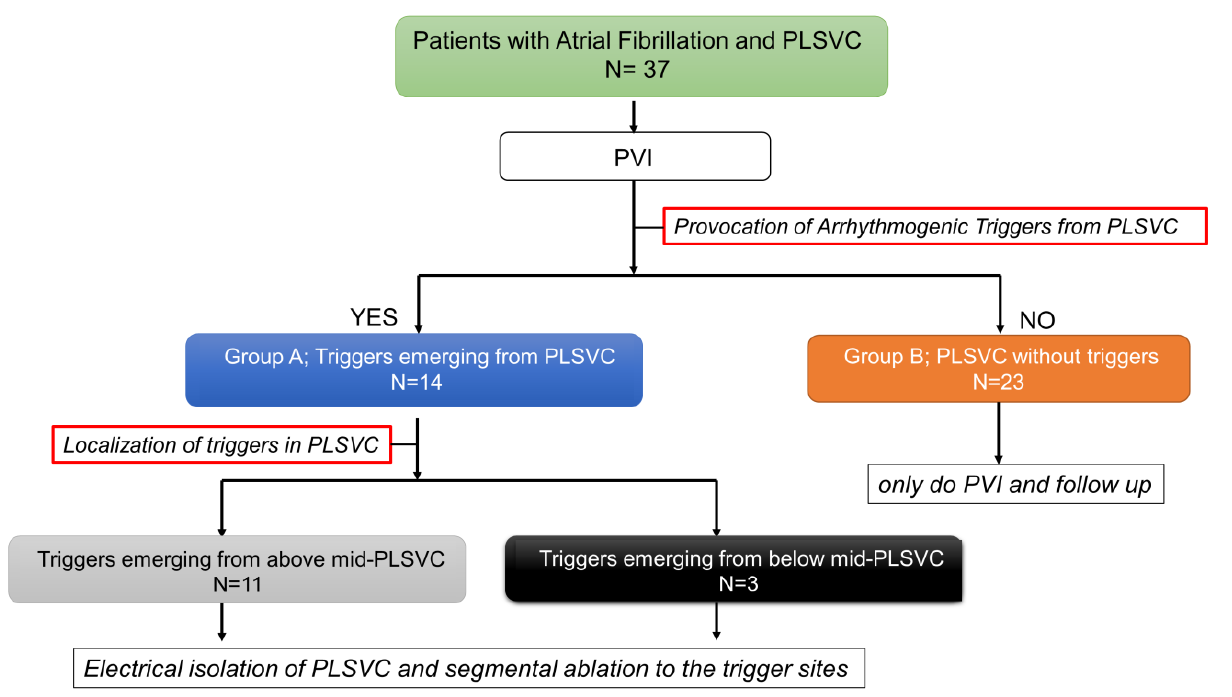
Figure 1. Diagram Flow Showing Patient Treatments and Procedures. PLSVC, persistent left vena cava; PVI, pulmonary vein isolation.